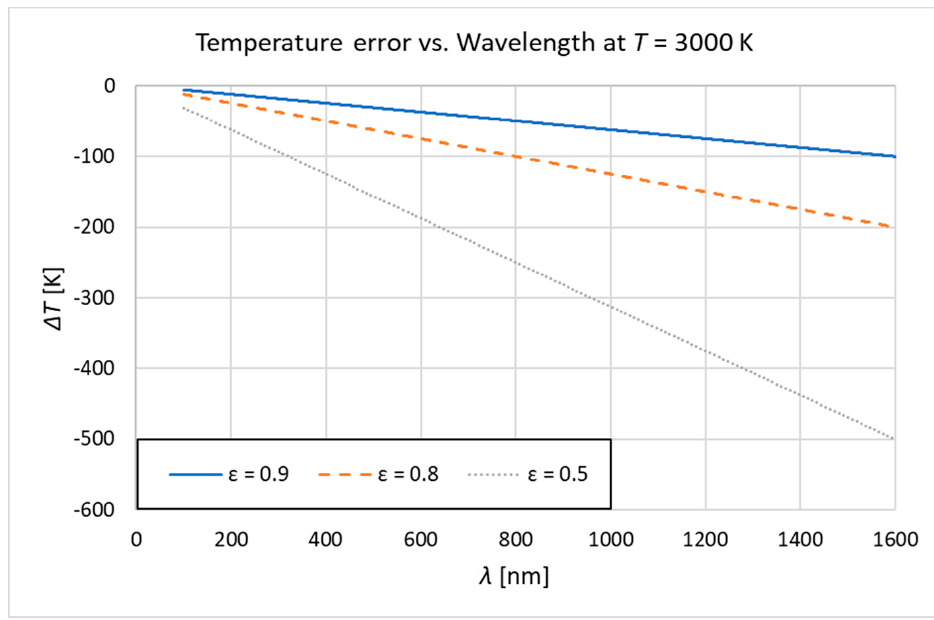
Figure 13. Plot of temperature error versus wavelength at T = 3000 K for different values of emissivity.